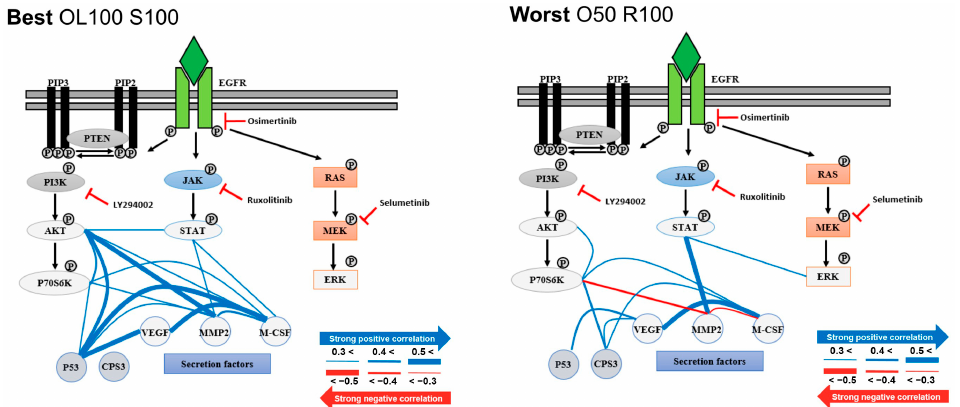
Figure 5. Correlation network for proteins in best (OL100 S100) and worst (O50 R100) drug groups. The blue line indicates a positive correlation between the two proteins and the red line indicates a negative correlation. The thickness of the line indicates the degree of correlation. O, Oximertinib; L, LY294002; R, Ruxolitinib; S, Selumetinib.